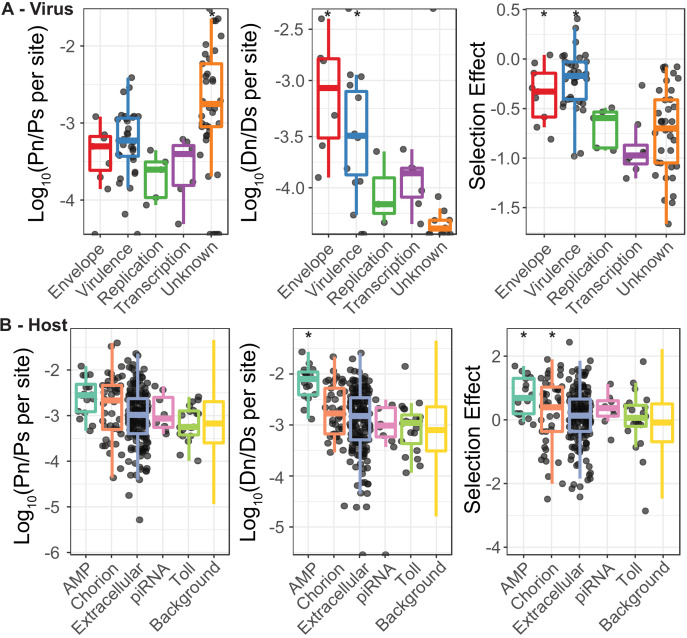
The ratio of nonsynonymous to synonymous polymorphisms and substitutions for both DiNV and D. innubila, used to generate Figure 4.(A) The ratio of nonsynonymous polymorphism (Pn) to synonymous polymorphism (Ps) for DiNV functional categories, the ratio of nonsynonymous substitutions (Dn) to synonymous substitutions (Ds) for DiNV functional categories and the resulting estimate of Selection effect (estimated using SnIPRE) for DiNV functional categories. (B) The ratio of nonsynonymous polymorphism (Pn) to synonymous polymorphism (Ps), the ratio of nonsynonymous substitutions (Dn) to synonymous substitutions (Ds) and the estimated Selection effect, all for the host D. innubila, separated by functional categories of interest highlighted in the differential expression analysis or the association study. We have included a point for each gene in all categories apart from the background, due to the sheer number of points in the background category. When 0 polymorphisms or substitutions are found in a gene, that gene is not shown in the Pn/Ps or Dn/Ds plots.